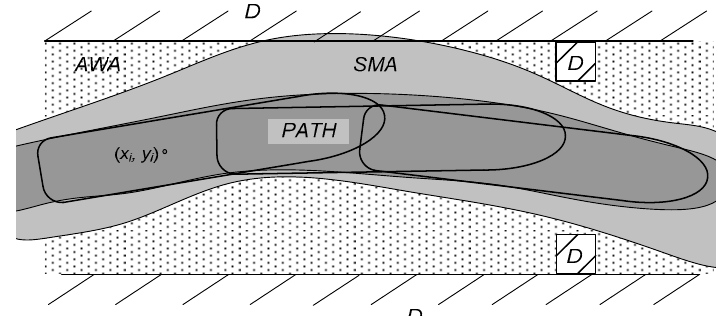
Figure 9. Definition of the ideas connected with horizontal areas taken by ships (PATH—lane of a single ship, AWA—available water area, SMA—safe manoeuvre area on the required confidence level, D—navigational danger).